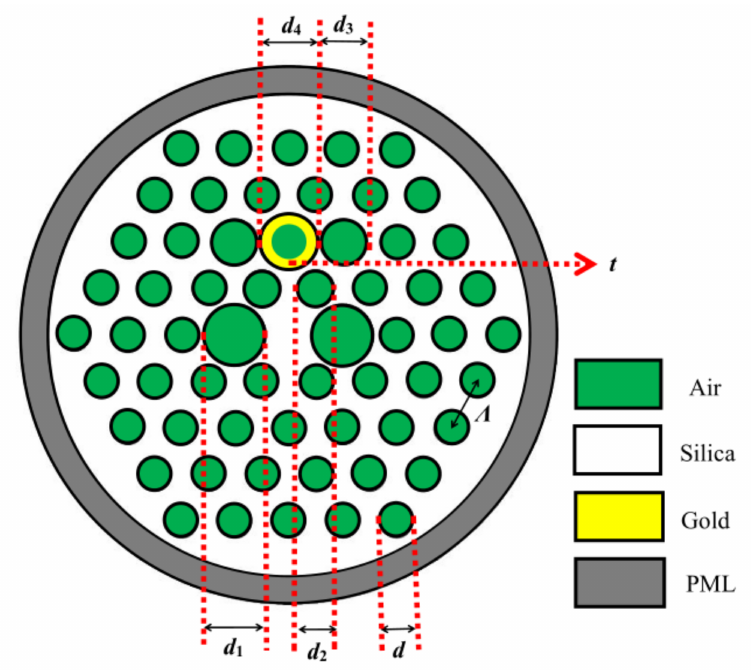
Figure 1. Cross-sectional schematic of the designed PCF polarization filter.